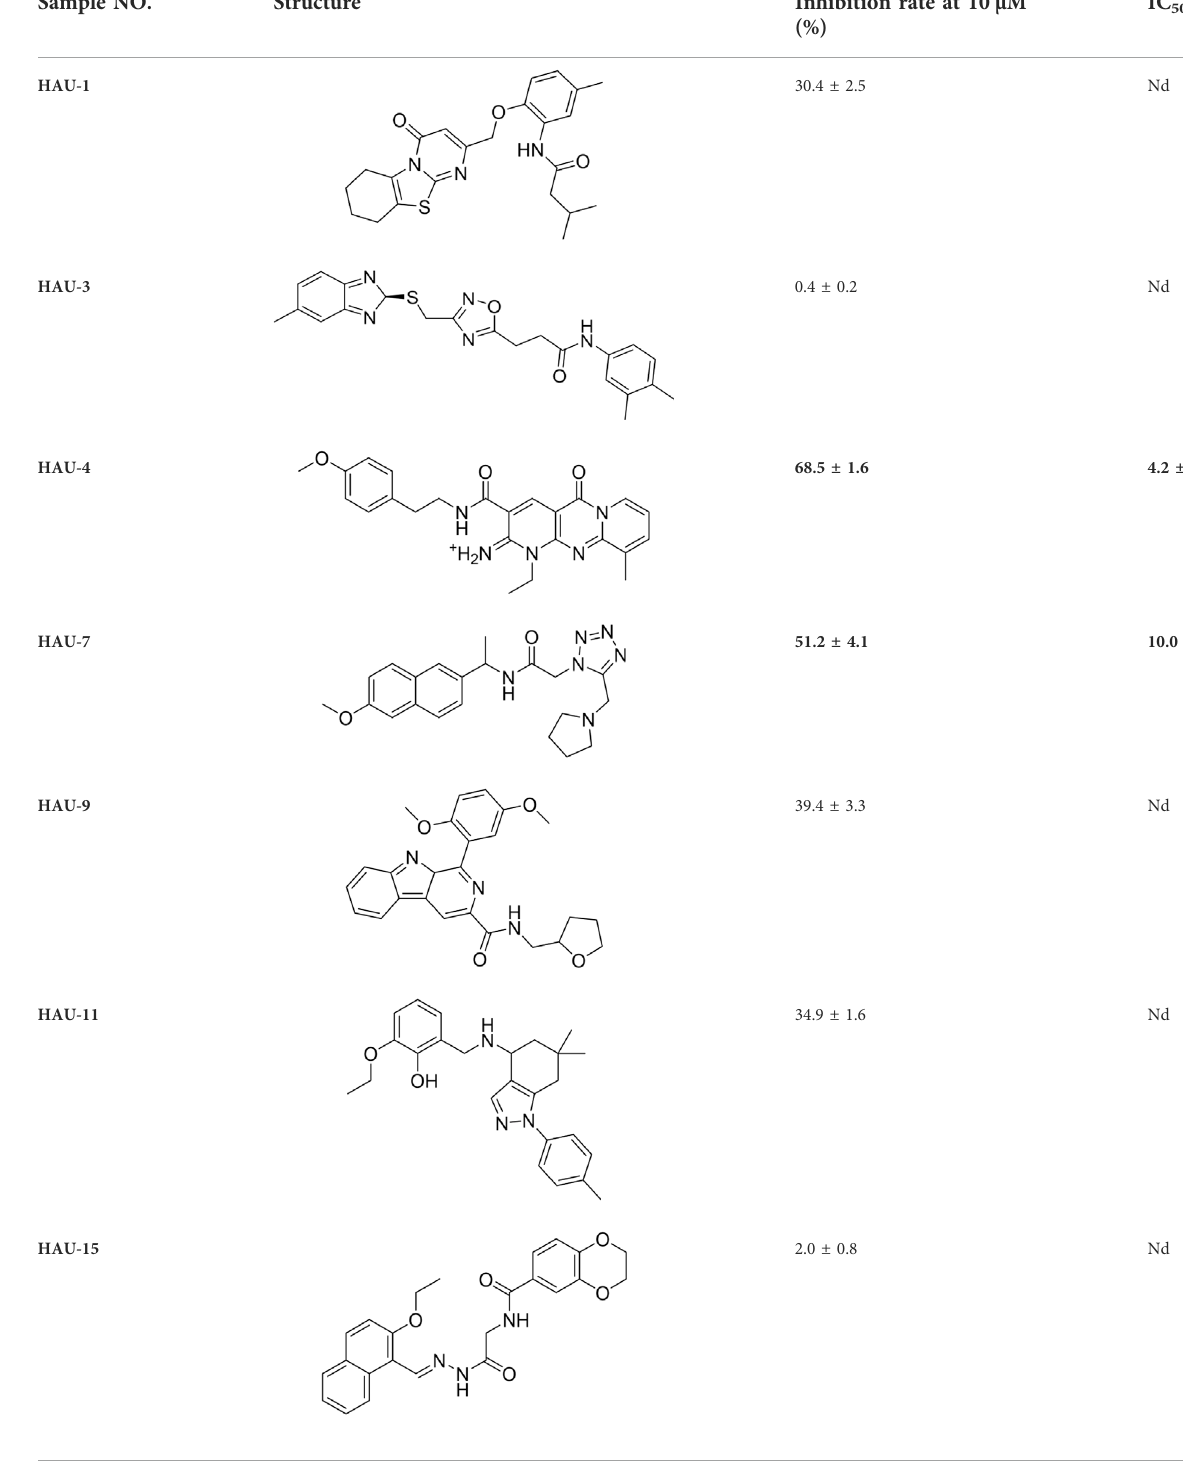
TABLE 1 Further inhibitory activity assays of representative compounds towards Ce Cht1. Sample